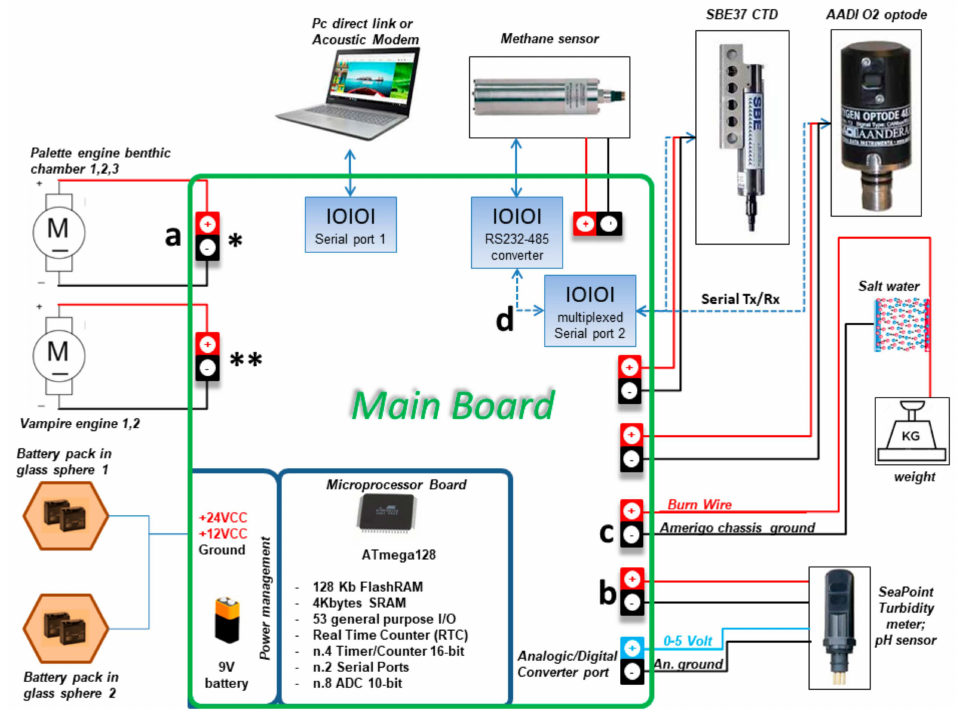
Figure A2. Electronics of the Amerigo Lander: Schematic drawing of the electronics diagram architecture. * Multiplied by three (palettes); ** multiplied by two (VAMPIRE motors); a: dedicated POWER-ON / OFF port (H bridge with electronic shunt); b: other “n” analogic devices; c: other “n”